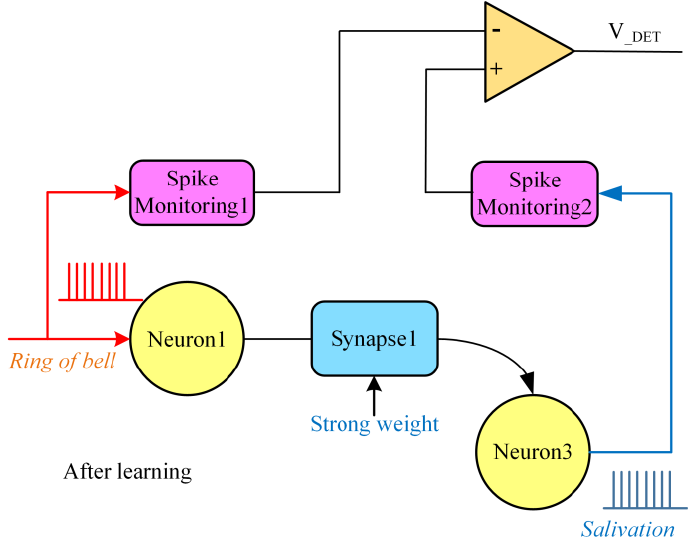
Figure 12. Circuit for radiation monitoring.